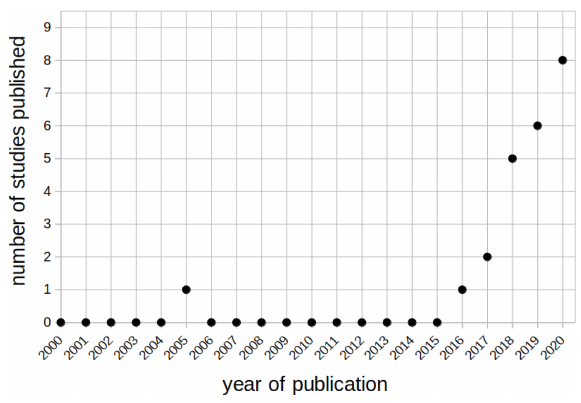
Figure 1. Number of studies on microplastic concentrations in ter- restrial soils published since the year